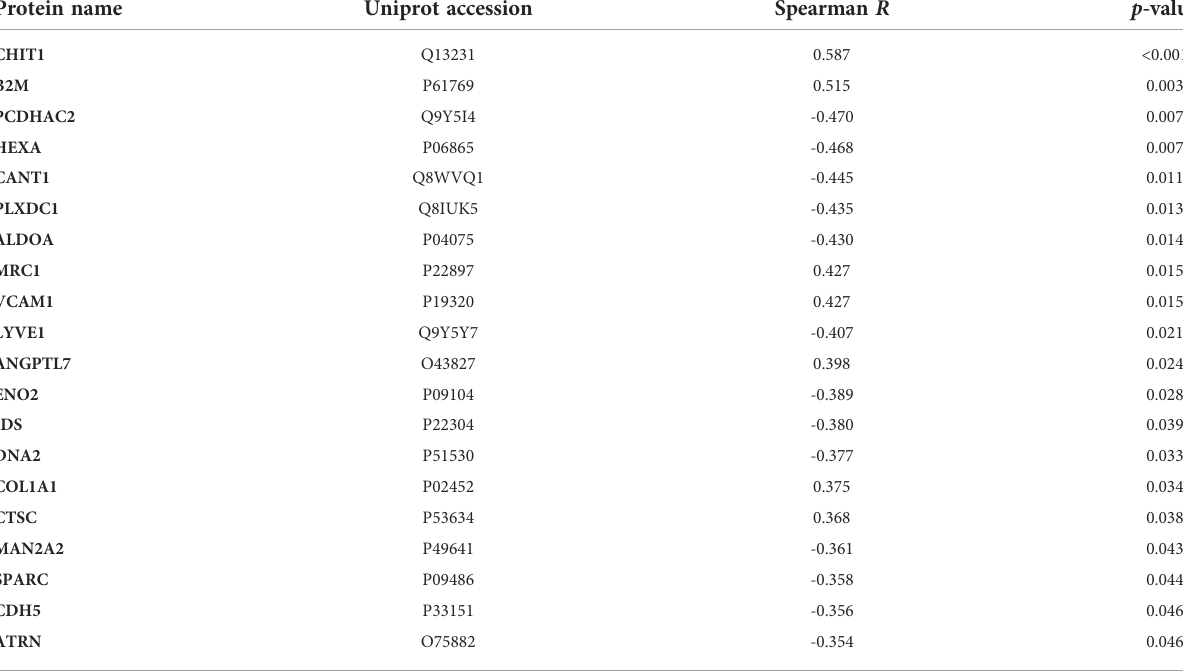
TABLE 1 Correlation between the LC-MS/MS protein intensity and the HAM/TSP progression